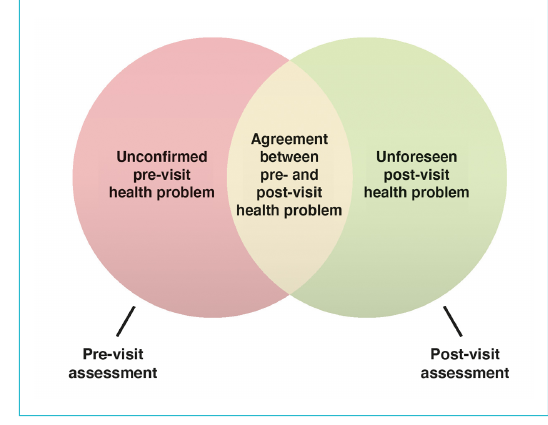
Figure 2: Intersection diagram. Definition of pre-visit and post-visit